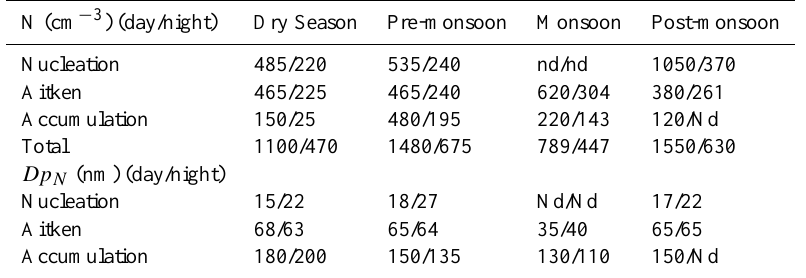
Table 1. Daytime and nighttime median integrated number concentrations and median geometric mean diameters for the nucleation, Aitken and accumulation modes and total number concentration during different seasons.